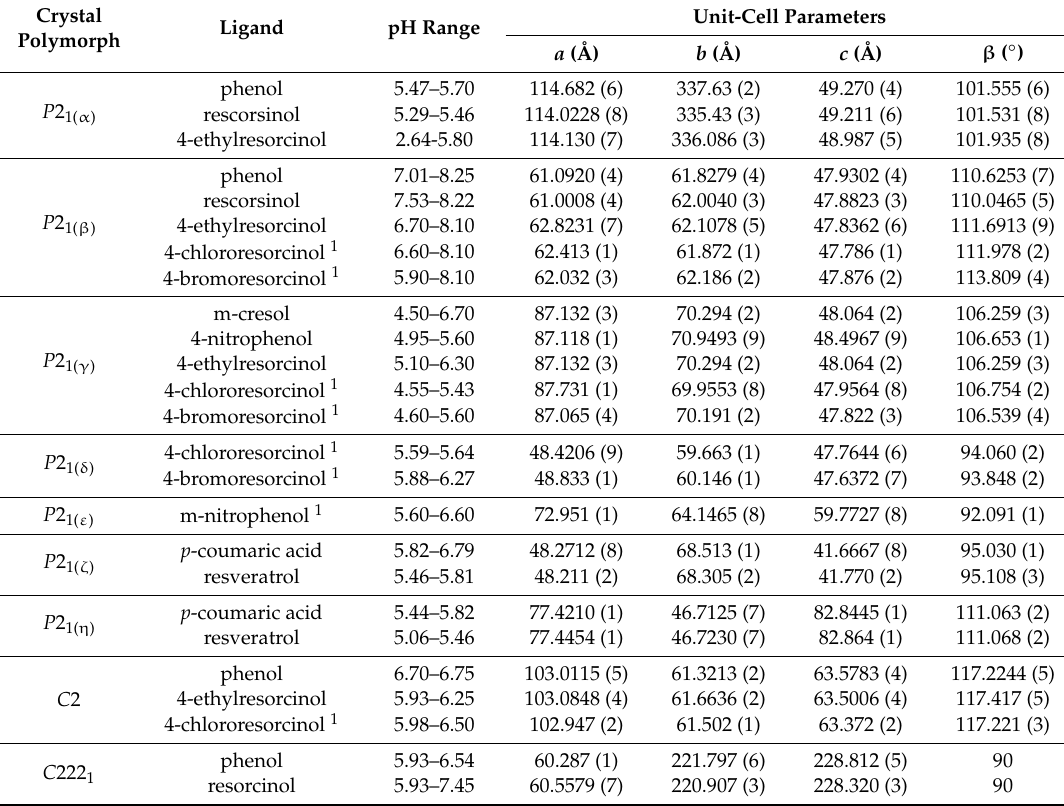
Table 2. List of recently reported HI monoclinic polymorphs as a function of di ff erent ligands and pH range. Precise unit-cell parameters, obtained by XRPD data, are